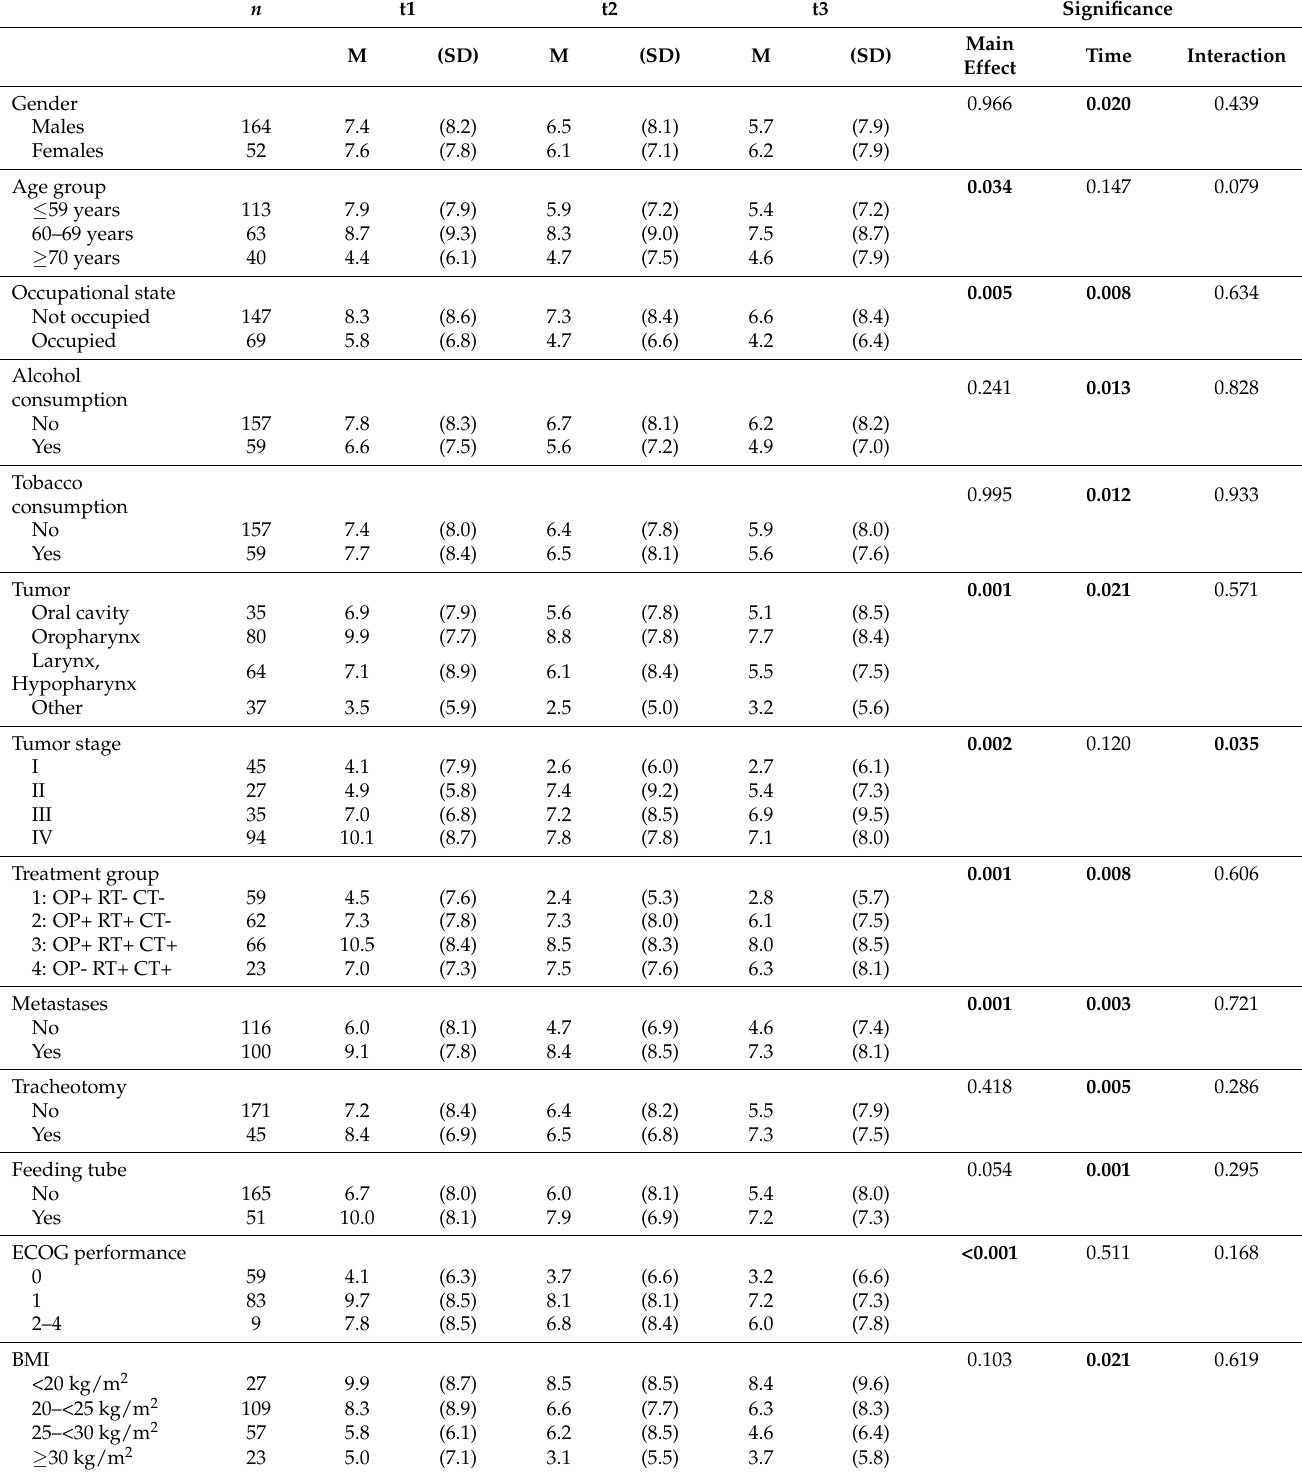
Table 3. Dysphagia: Mean scores depending on sociodemographic and clinical